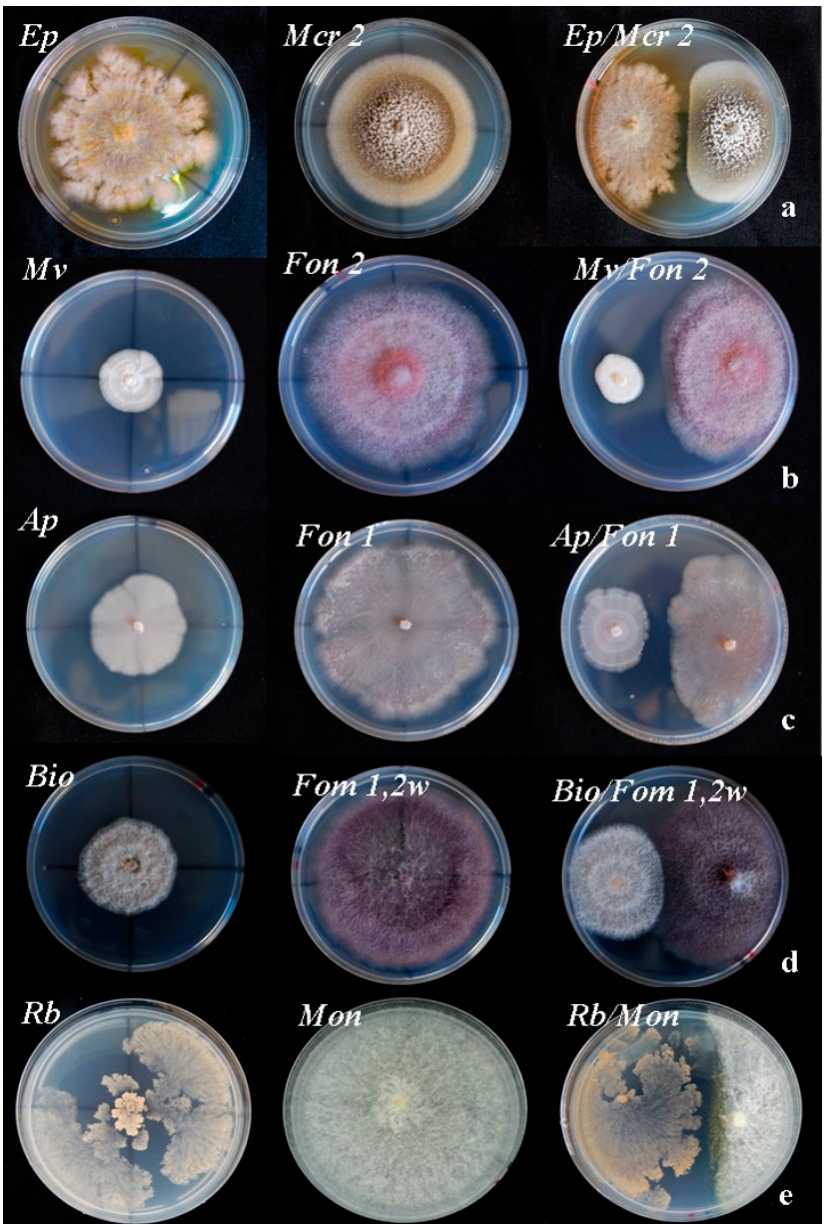
Figure 3. Effect of inhibition of the rest of antagonists on the growth of several pathogens. From left to right there are control plates of both antagonists and pathogens followed by the dual culture plate. ( a ): E. purpurascens (Ep ) / M. phaseolina ( Mrc2 ). ( b ) M. verrucaria ( Mv ) / Fon 2 . ( c ): A. pullulans ( Ap ) / Fon 1 . ( d ): B. ochroleuca ( Bio )/ Fom 1.2w . ( e ): Binucleate Rhizoctonia ( Rb )/ M. cannonballus ( Mon ).